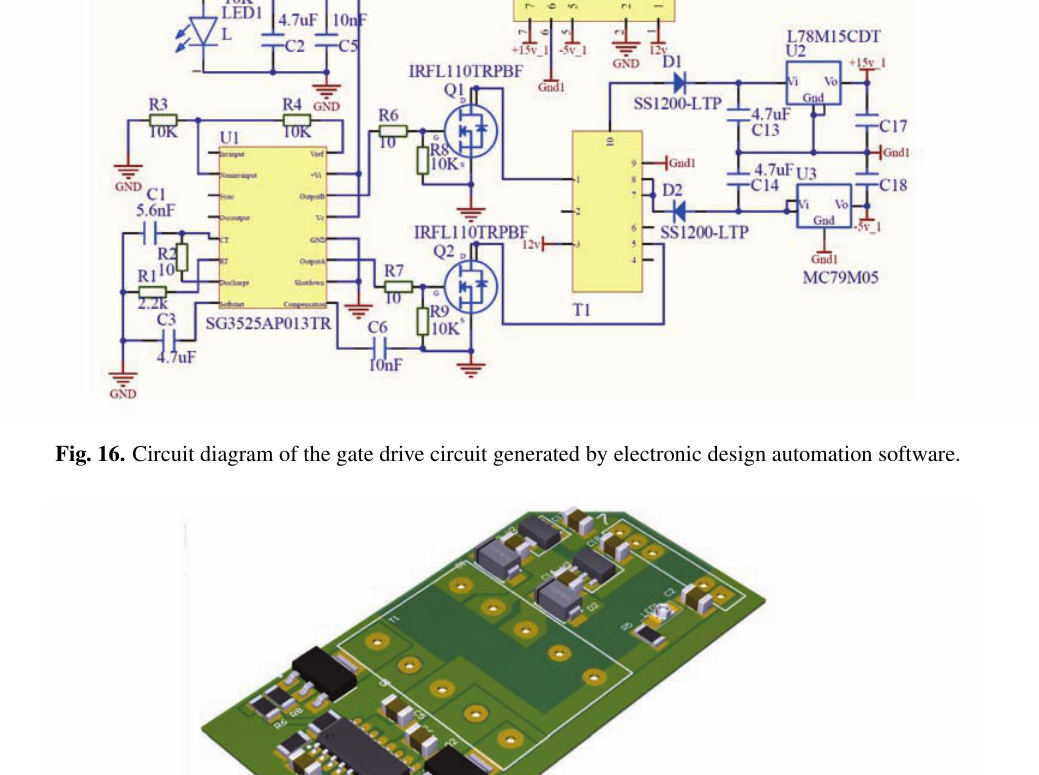
Fig. 15. Sine Pulse Width Moduulation to generate smooth sine at tthe output of the inverter.